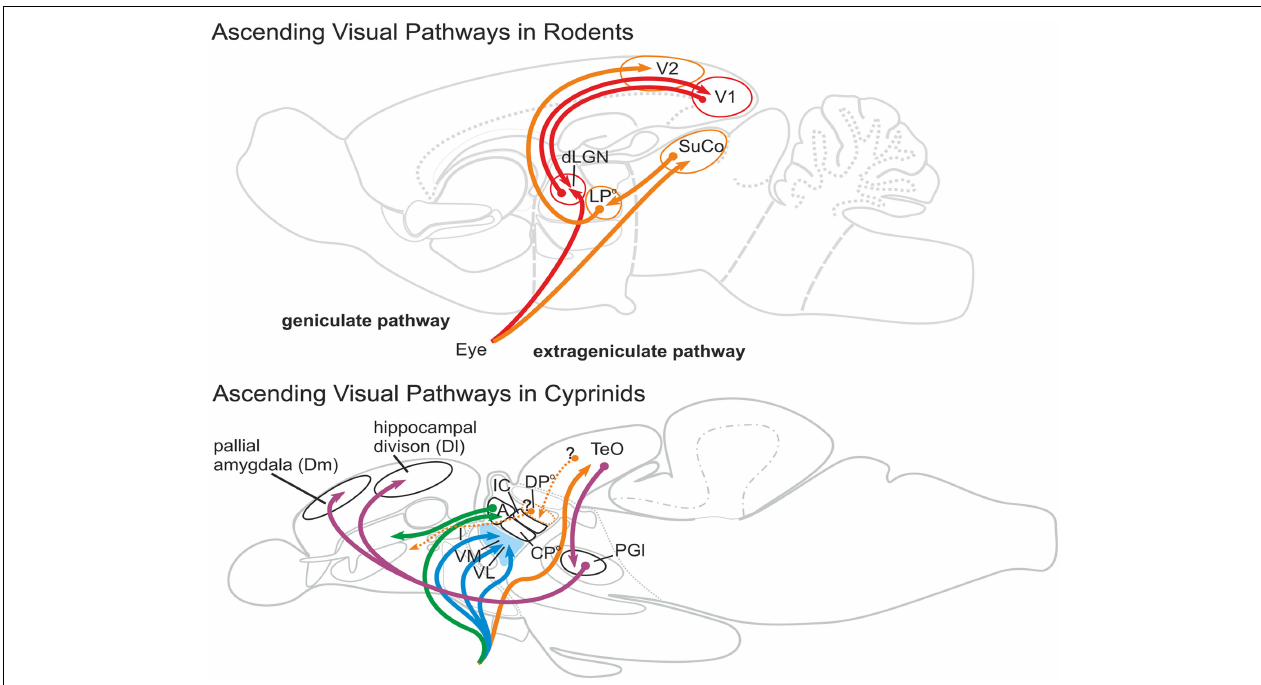
(VL) thalamic nuclei), as well as the anterior nucleus (green, A), and the tectum opticum (orange) which is homologous to the mammalian superior colliculus (SuCo). Based on studies in some teleosts, the dorsoposterior thalamic nucleus (DP o ) of cyprinids does likely receive visual information from the tectum opticum (TeO) and, thus, likely represents the visual thalamic nucleus. However, this nucleus does project to the striatopallidum (Vd), but not to any pallial area.The only thalamus-like visual relay nucleus is the lateral preglomerular nucleus, which projects to the dorsomedial pallial amygdala (Dm) and to the laterodorsally located hippocampal divsion (Dl; projections in purple).Thus, geniculate and extrageniculate pathways as found in mammals are absent in